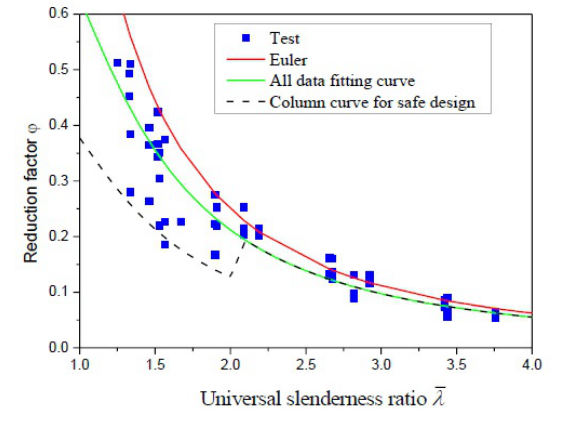
Figure 12: Comparison of stability factor curves for CFRP